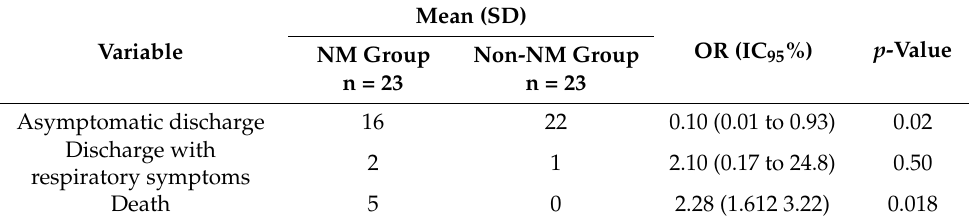
Table 5. Outcomes in pediatric patients with